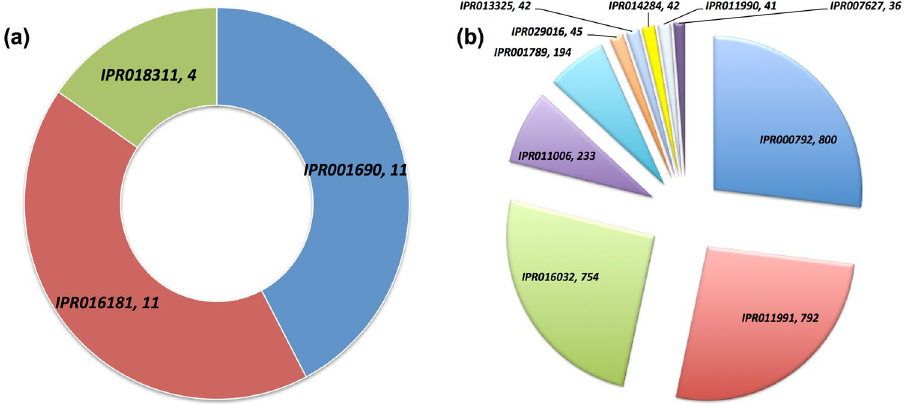
Figure 2. Statistical distribution of the domains that are maximum preferred ( a ) unique domains extracted in LuxI containing protein from InterPro, ( b ) unique domains extracted in LuxR containing protein from